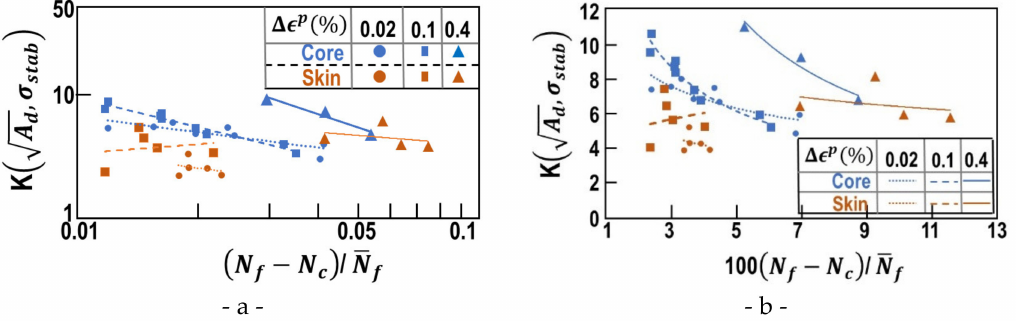
Figure 16. Correlation between stress intensity factor based on the initial defect area A d and the normalized number of cycles in stage II. ( a ) Classical representation with ( b ) the same results in cartesian